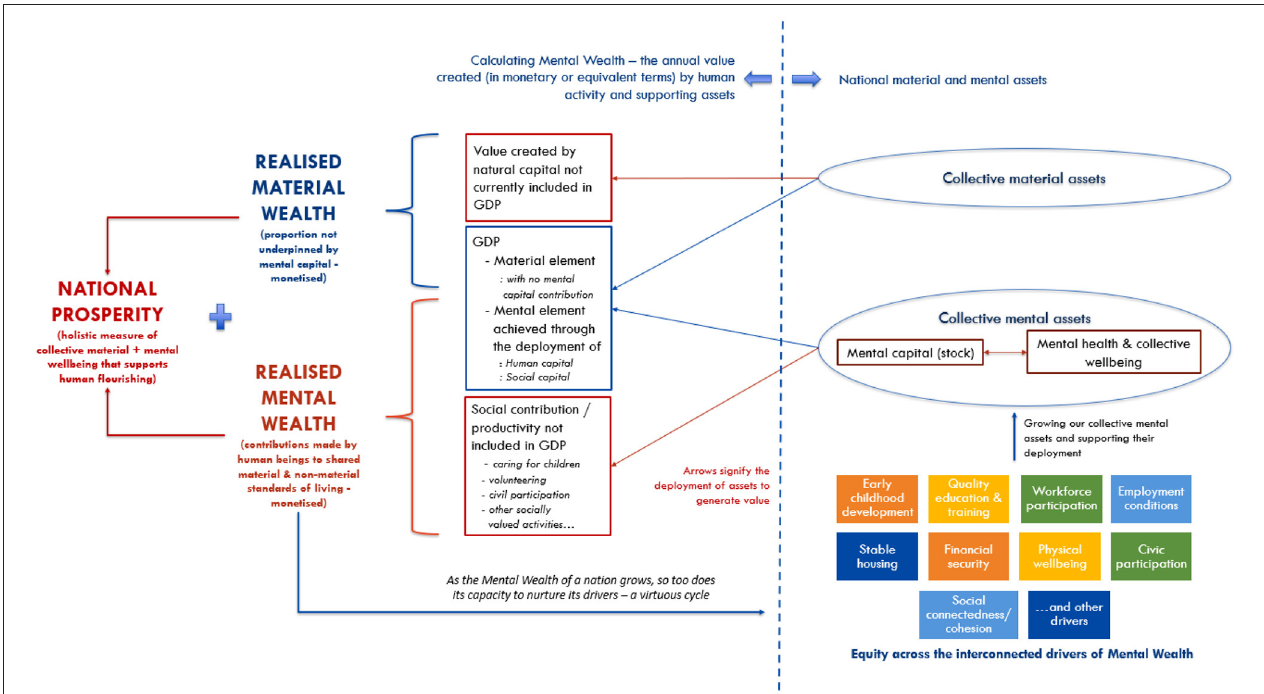
FIGURE 1 | Operationalizing Mental Wealth: an initial